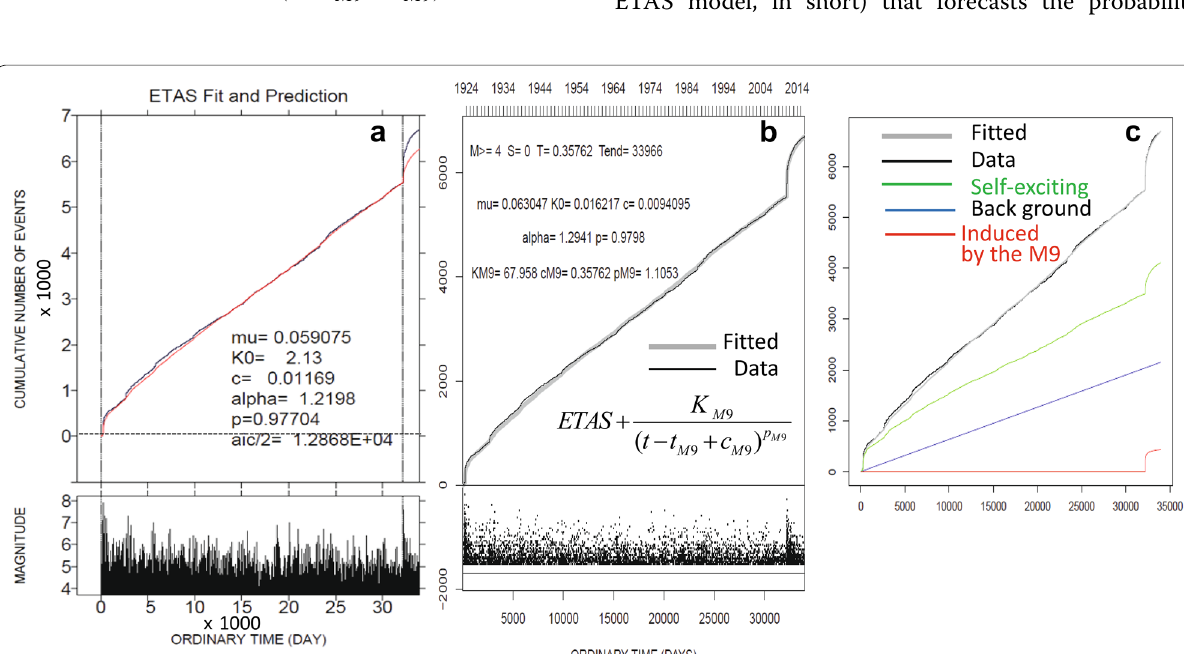
Fig. 2 Fitting of temporal models. The identical rising black lines in the three panels show the cumulative numbers of earthquakes of M4 and larger in the Kanto region, against the elapsed time over the entire period. a The red cumulative curve shows the theoretical numbers of M4 earthquakes and larger, from the beginning of the period. This was estimated using the ETAS model, fitted in the target period up until the time of the M9 Tohoku-Oki earthquake (indicated by the right side vertical dotted line), and extrapolated after that. b The thick gray line represents the expected cumulative curve obtained from model Eq. (1). c This panel shows the decomposition of the expected contributions to earthquake numbers, in the combined model Eq. (1), by background, self-triggering, and induced